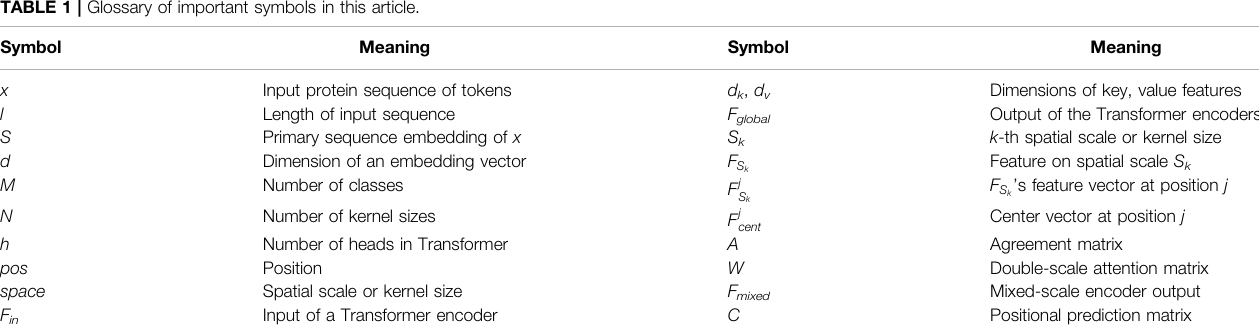
TABLE 1 | Glossary of important symbols in this article.